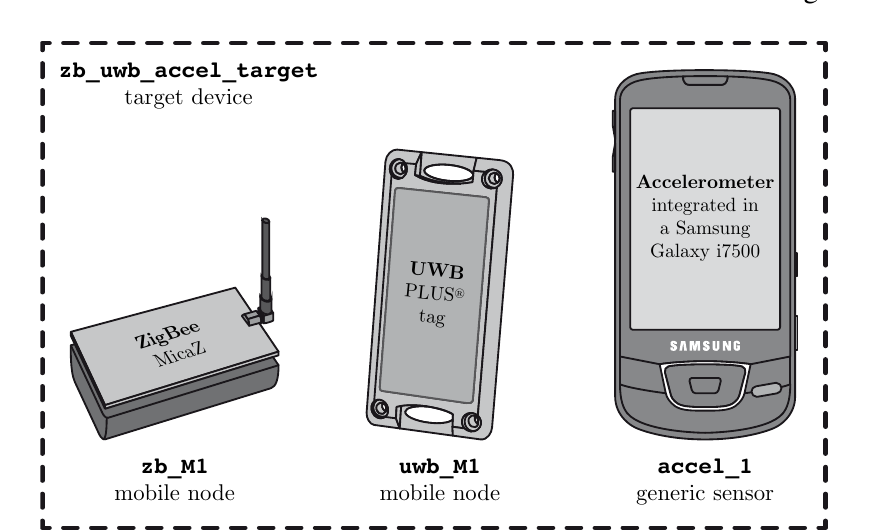
Figure 5. The zb uwb accel target identifier represents a virtual target device, and it is associated to the zb M1 and uwb M1 mobile devices and to the accel 1 generic